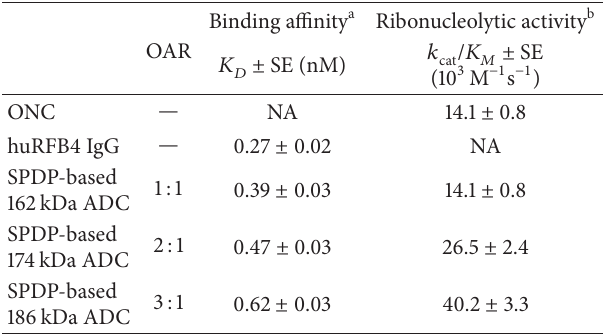
Table 1: Binding affinity and ribonucleolytic activity of SPDP-based